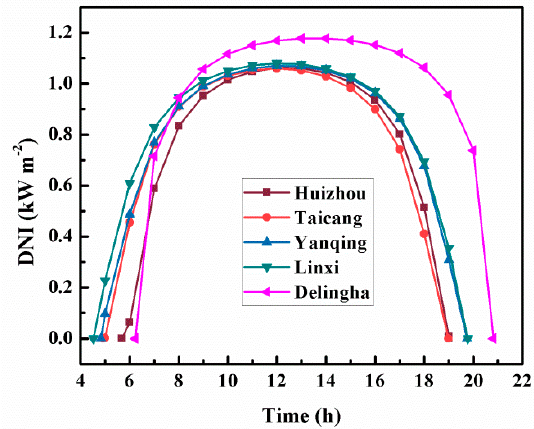
Figure 4. Direct normal irradiances (DNIs) of summer solstice in different locations.